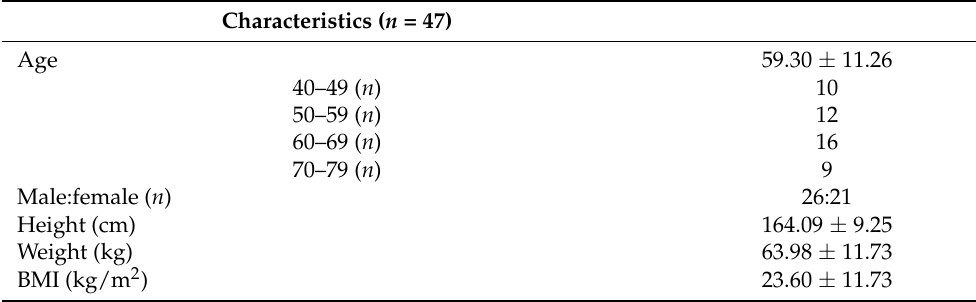
Table 1. Demographic characteristics of all